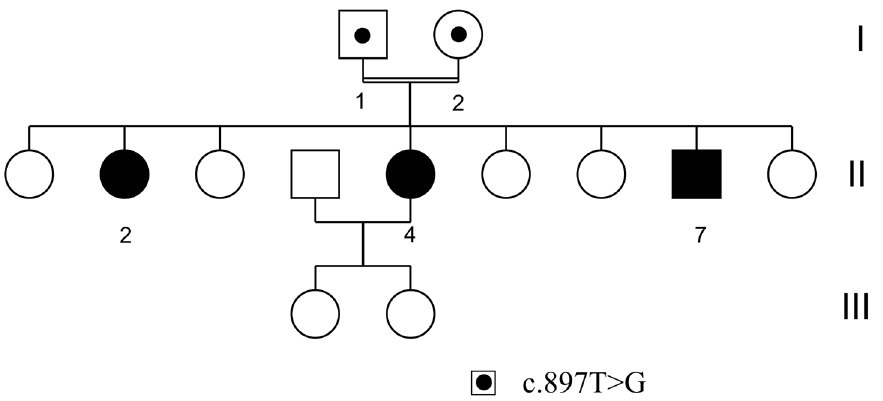
Figure 1. Pedigree of the XP family. Black symbols refer to affected individuals. Black dots into first generation individuals symbols (I:1 and I:2) represents the POLH c.897T . G mutation at heterozygous state.